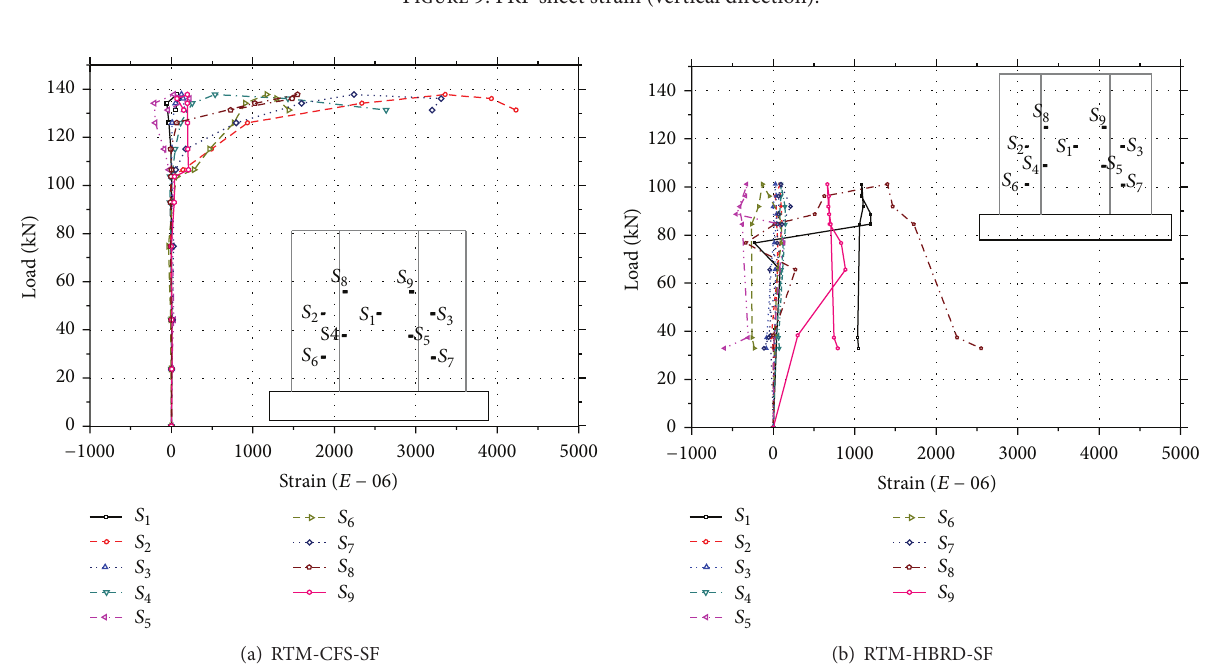
Figure 10: FRP sheet strain (horizontal